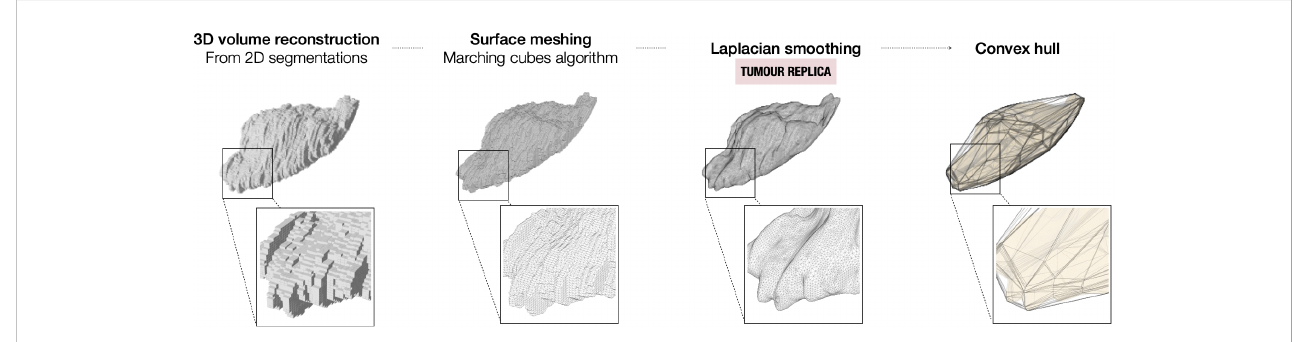
FIGURE 2 Steps for the modelling of the tumour from the 2D segmentations on the preoperative